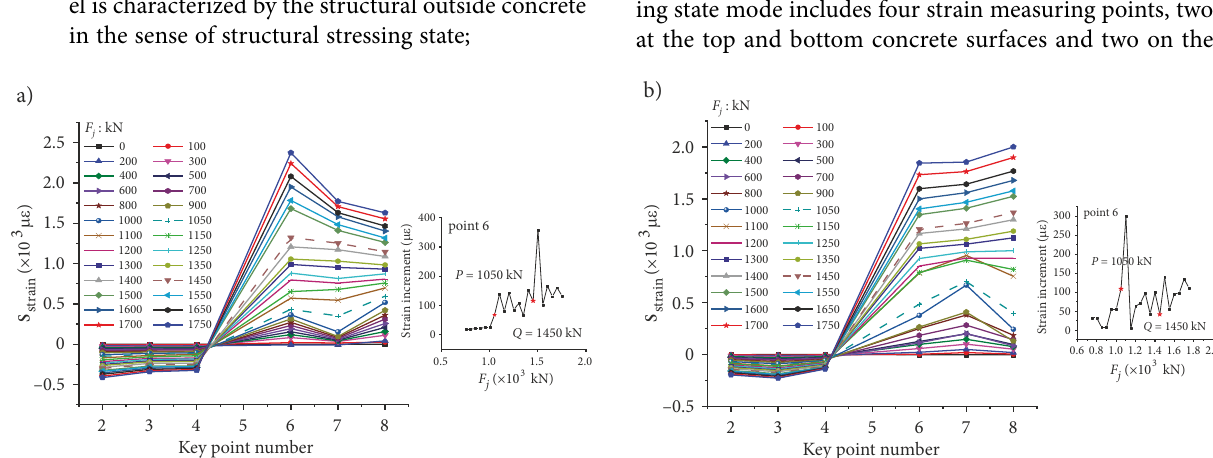
stateFigure 8. The changing feature of strain-based stressing state modes for cross sections: (a) the change of stressing state mode for the surface concrete of section B; (b) the change of stressing state mode for the steel bars of section